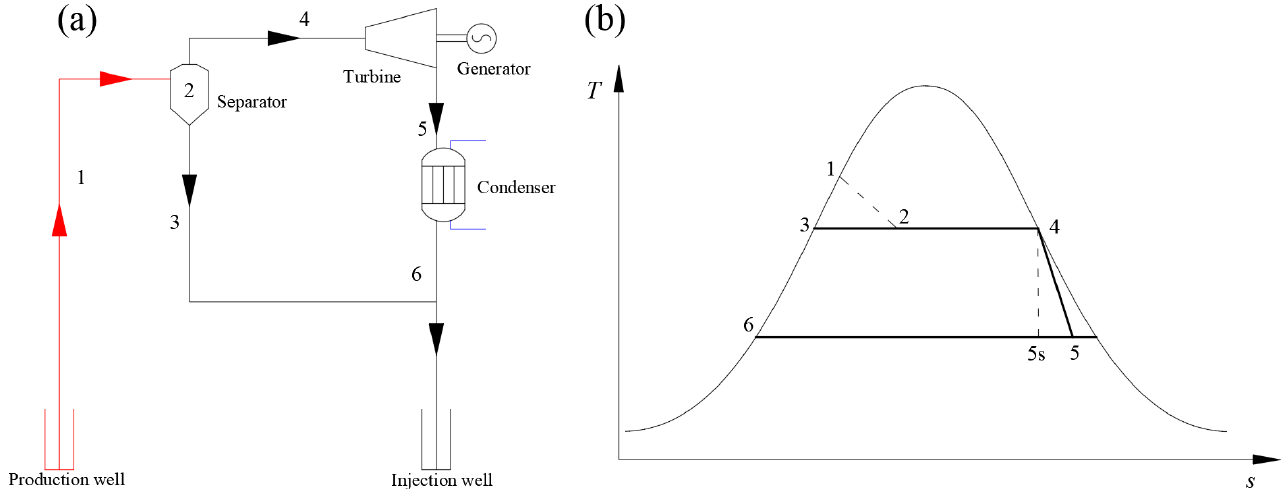
Figure 1. The schematic diagram and T-s diagram of the SF system ( a ) schematic diagram; ( b ) T-s diagram